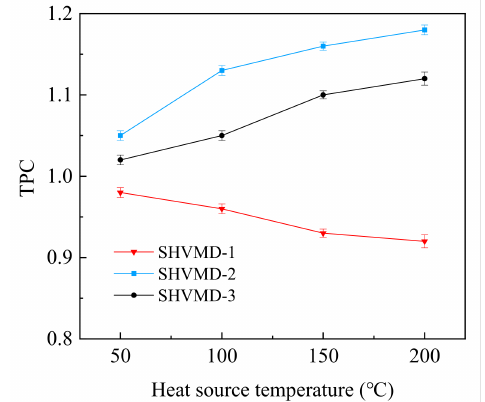
Figure 4. TPC changes with heat source temperature in different